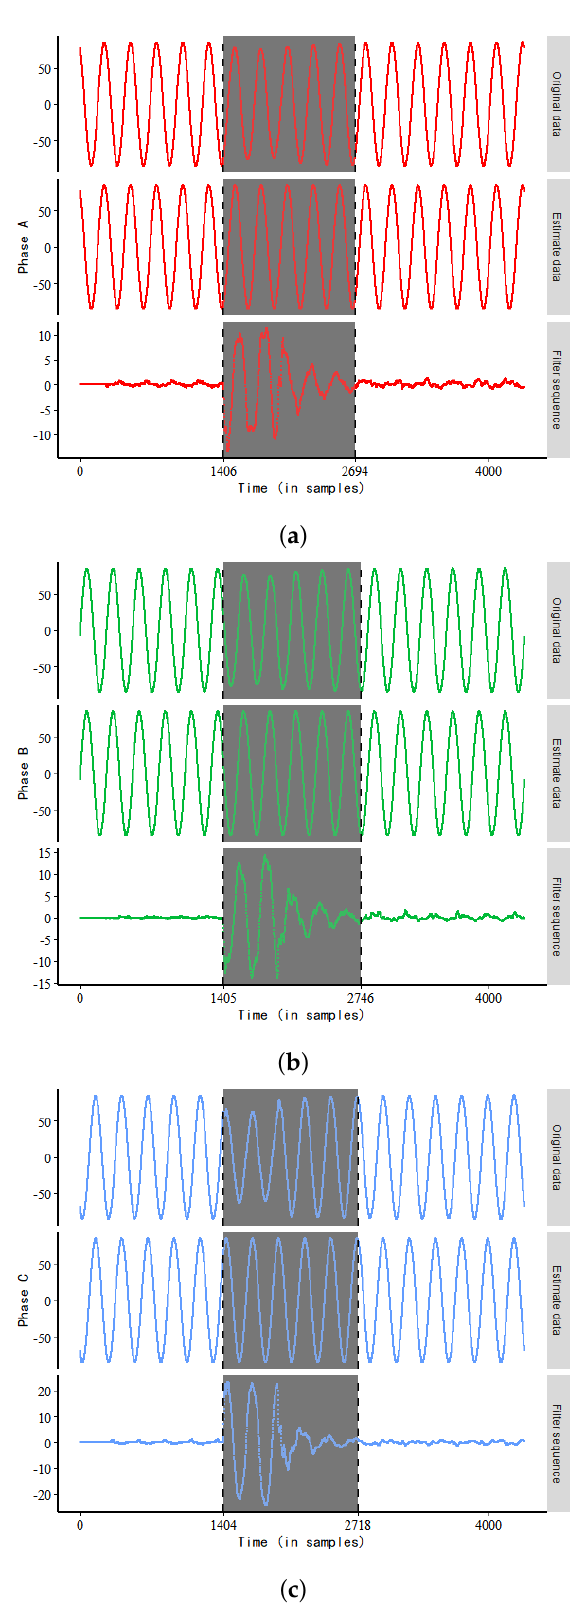
Figure 7. FPSA for voltage sag data (id 01), where subfigures ( a – c ) represent the three-phase voltage sag data